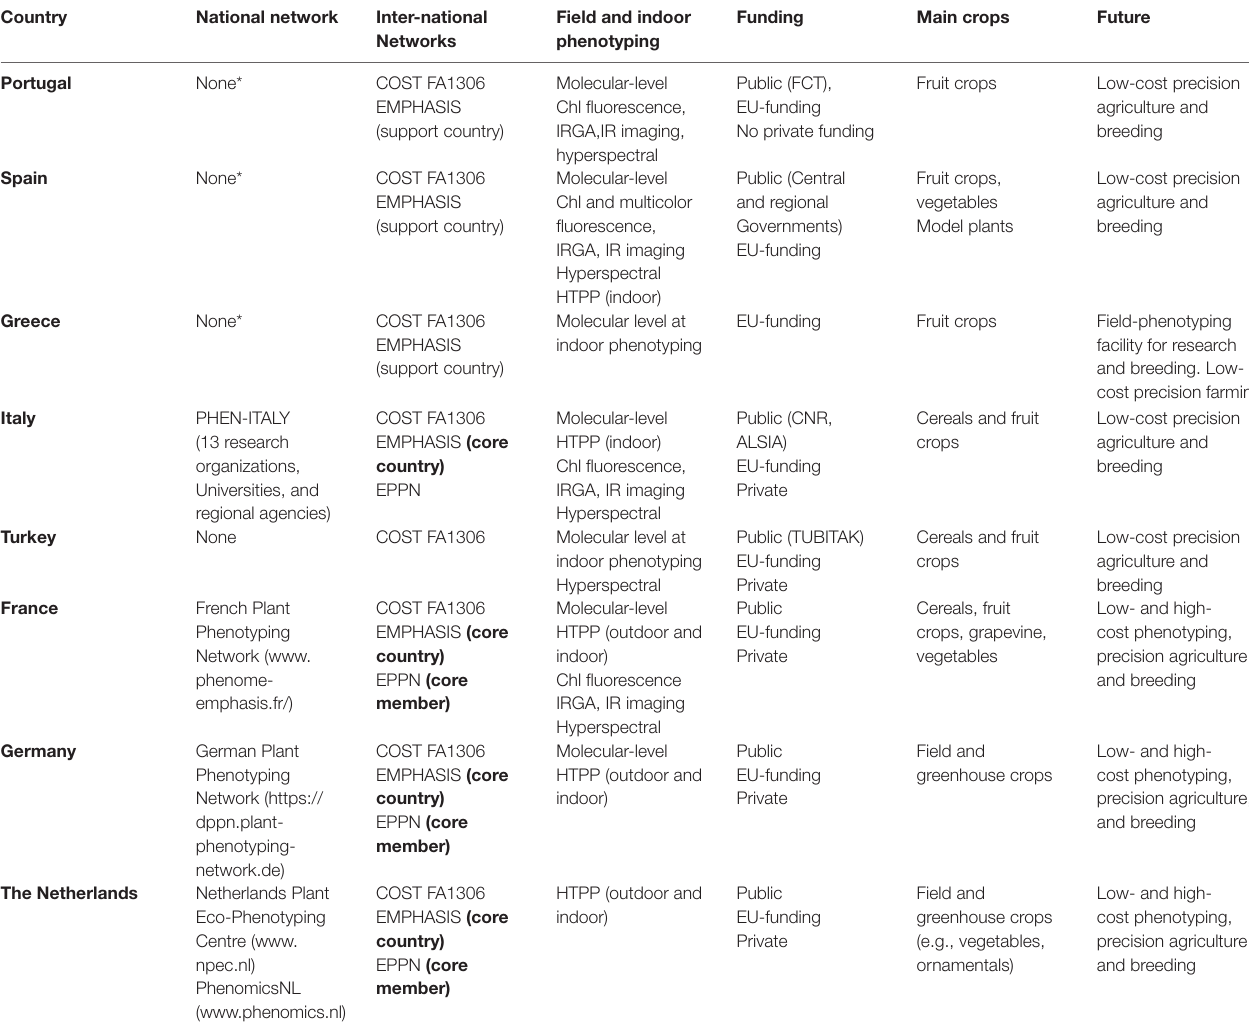
TABLE 1 | Summary of the major characteristics of phenotyping activities developed in EU countries analyzed in this study (Portugal, Spain, Italy, and Greece) and in Turkey. Data on French, Dutch, and German situations is provided as examples of advanced levels of phenotyping approaches/technology and to enable a more robust comparison between Northern and Southern EU